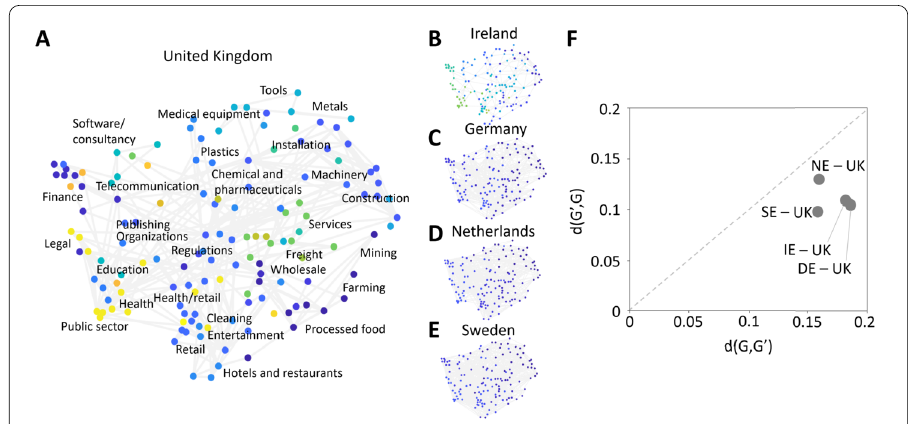
Figure 7 The pairwise comparison of the modular structure of the United Kingdom (UK) to four different countries’ SRNs, namely: Ireland (IE), Germany (DE), the Netherlands (NE), and Sweden (SE). In ( A ) we show the UK SRN. The nodes represent industries and edges the skill-relatedness between the two corresponding industries. Nodes are coloured according to their community (found using the modularity optimization algorithm). The same node layout is used as in Fig. 4. Labelling is added to indicate the general position of sectors within the network. Using the same layout we also show communities detected for IE, DE, the NE and SE in subfigure ( B ) to ( E ). In ( F ) we show the resulting BiDir distance from the pairwise comparison of the UK SRN to the other countries’